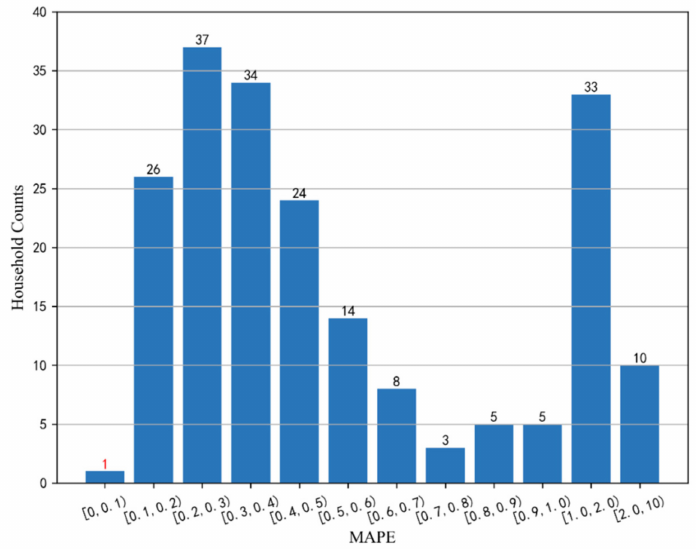
Figure 7. Histogram of MAPE values of forecasting results on 31 March for the selected 200